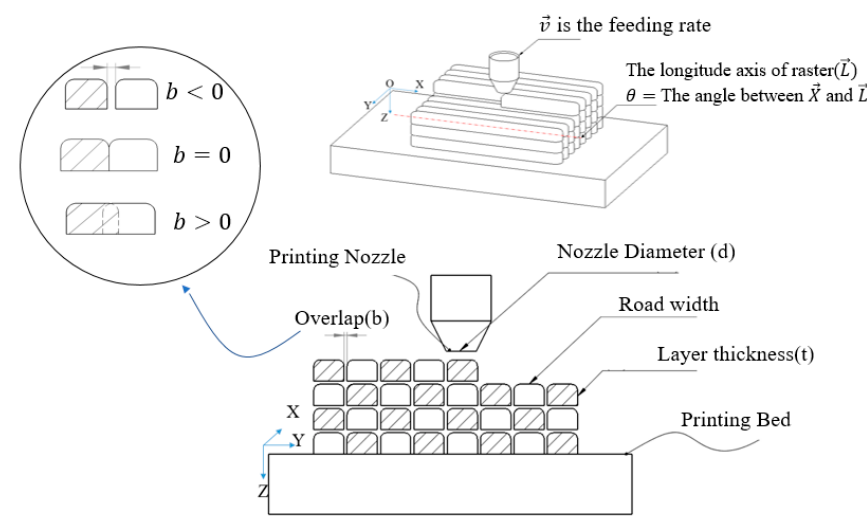
Figure 1. FDM main process parameters.